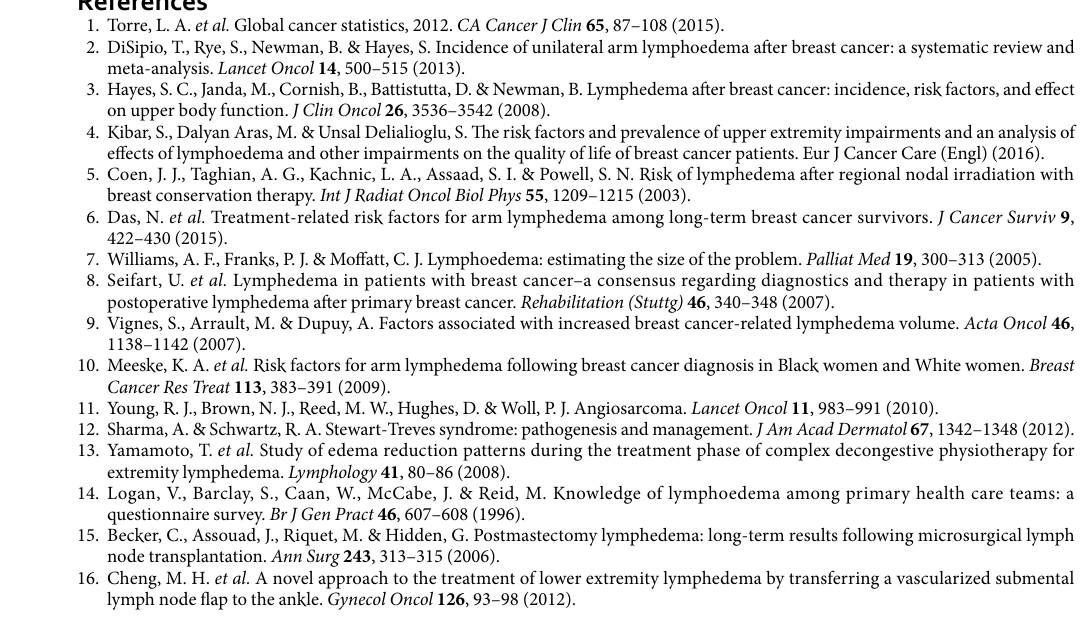
5 Scientific RepoRts | 7: 80 | DOI:10.1038/s41598-017-00164-1